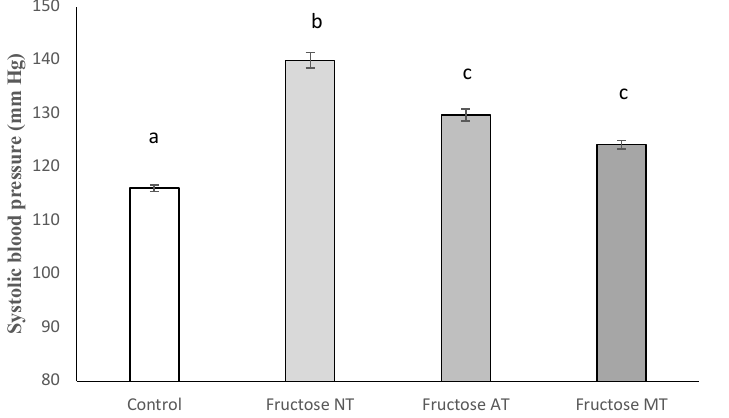
Figure 4. Systolic arterial blood pressure at the end of the experiment (week 8). Different letters show significant differences at ( p < 0.05).